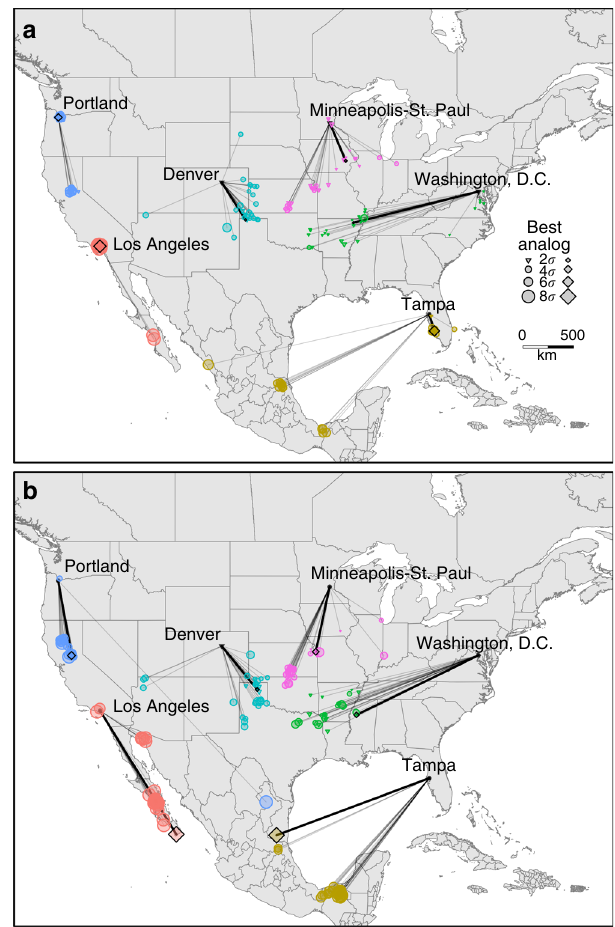
Fig. 4 Variation in climatic analogs by future climate scenario. For each of the six example cities, colored triangles and circles indicate the location of the best contemporary climatic analog to 2080 ’ s climate for the 27 future climate scenarios for a RCP4.5 and b RCP8.5. Triangles indicate representative contemporary analogs (<2 σ ) and circle size indicates increasingly poor analogs. Colored diamonds and bold lines indicate contemporary climatic analogs for the ensemble mean across the